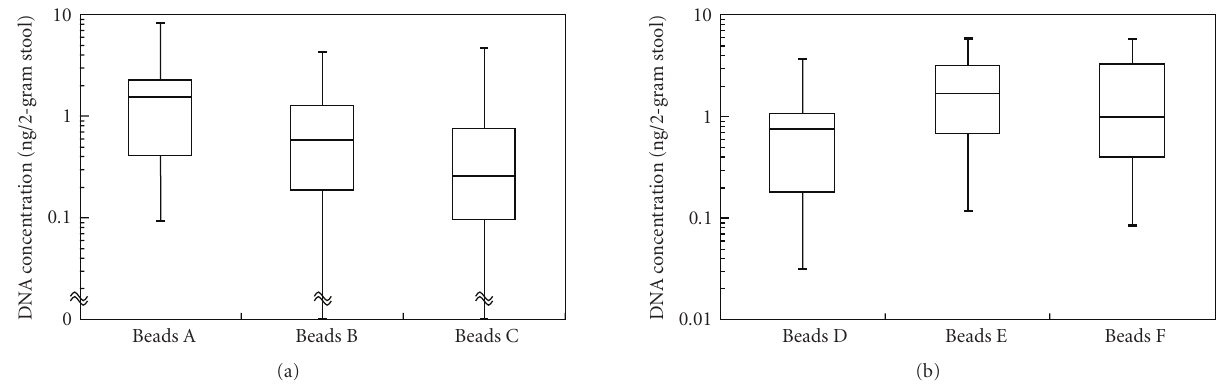
Figure 3: Cell retrieval ability of newly developed immunomagnetic beads in clinical samples. (a) Cell retrieval ability using several sized immunomagnetic beads in clinical samples. The median amounts of DNA from 2-gram stool using beads A (smallest, 3.0 μ m), beads B (medium, 4.9 μ m), and beads C (largest, 5.9 μ m) are 1.50ng (range; 0.09–8.12), 0.58ng (range; 0–4.23), and 0.25ng (range; 0–4.62), respectively. The horizontal bar is a median amount of extracted DNA from isolated colonocytes from 2-gram stool; the upper vertical bar is a maximal amount of extracted DNA; the lower vertical bar is a minimal amount of extracted DNA; and the column contained 50% of these populations. (b) Cell retrieval ability using immunomagnetic beads tagged with several a ffi nities mAbs in clinical samples. The median amounts of DNA from 2-gram stool using beads D (tagged with a lower a ffi nity mAb, Clone 1-2), beads E (tagged with a higher a ffi nity mAb, Clone B8-4), and beads F (tagged with a higher a ffi nity mAb, Clone B8-7) are 0.75 ng (range; 0.03–3.65), 1.66ng (range; 0.12–5.74), and 0.99 ng (range; 0.08–5.67), respectively. The horizontal bar is a median amount of extracted DNA from isolated colonocytes from 2-gram stool; the upper vertical bar is a maximal amount of extracted DNA; the lower vertical bar is a minimal amount of extracted DNA; and the column contained 50% of these